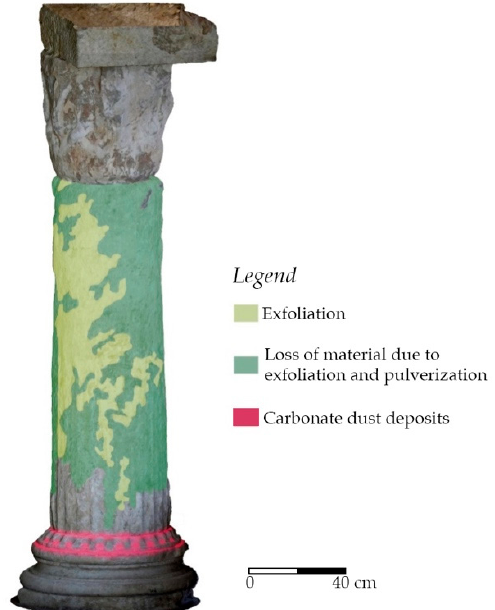
Figure 2. Degradation forms affecting the analysed column shaft.